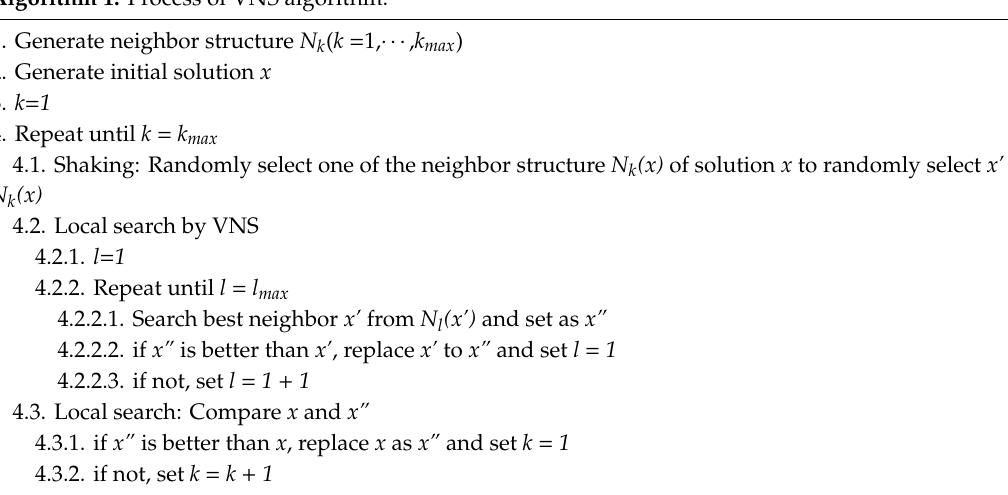
Algorithm 1: Process of VNS